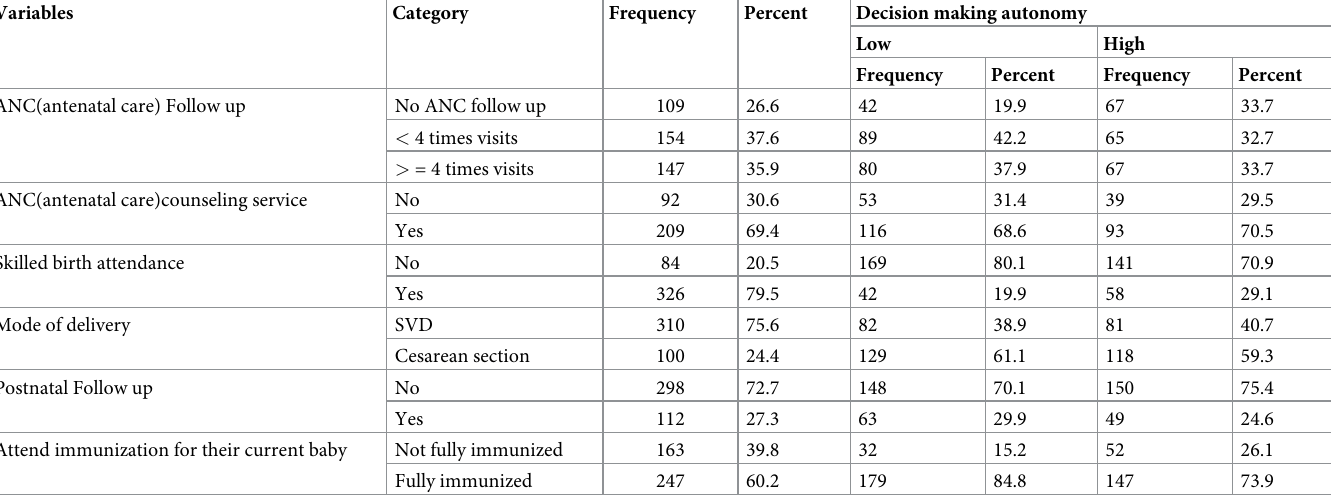
Table 3. Health service utilization and proportion of decision making autonomy among postpartum mothers in Shashamane town, Oromia, Ethiopia, 2021 (N = 410). Variables